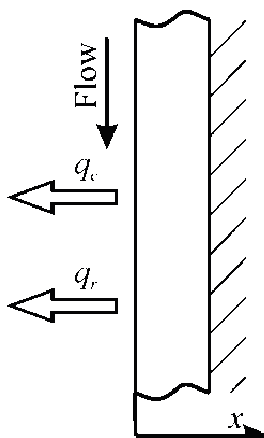
Figure 9. Sketch of the thin skin